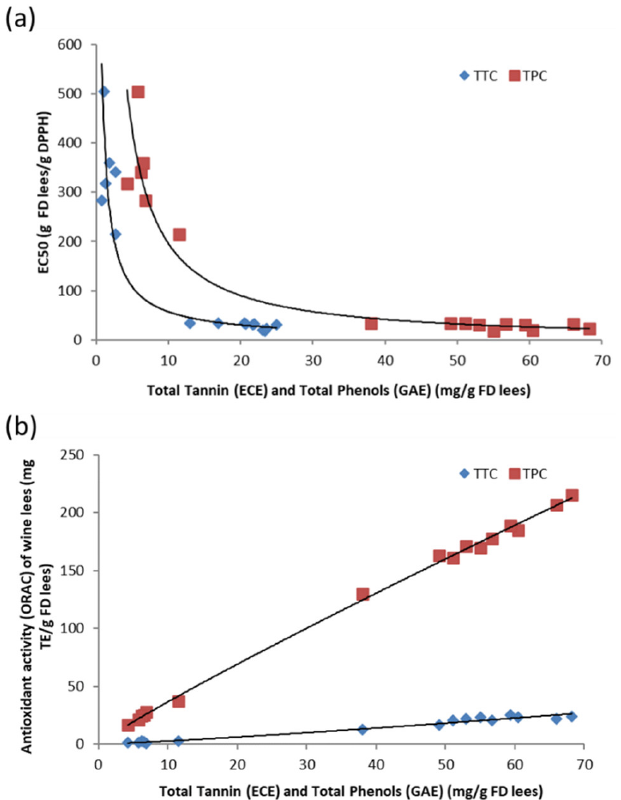
Figure 4. ( a ). The relationship between EC 50 of wine lees extracts and their TTCs and TPCs; ( b ). The relationship between oxygen radical antioxidant capacity (ORAC) of wine lees extracts and their TTCs and TPCs. ECE represents epicatechin equivalent and GAE represents gallic acid